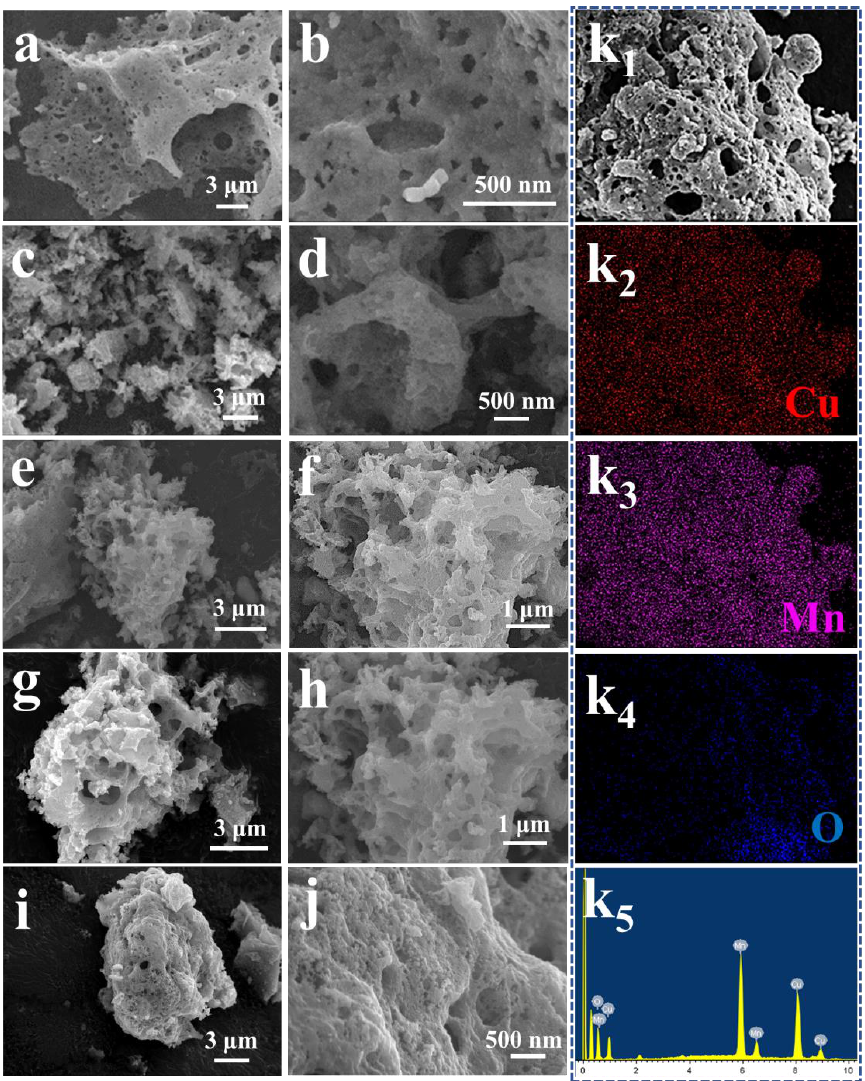
Figure 3. SEM images of Mn 2 O 3 ( a , b ), Cu 1 Mn 2 O 4 ( c , d ), Cu 1.5 Mn 1.5 O 4 ( e , f ), Cu 2 Mn 1 O 4 ( g , h ) and CuO ( i , j ). Cu, Mn and O elemental mapping recordings from Cu 1.5 Mn 1.5 O 4 ( k 1 – k 4 ) and the EDS result ( k 5